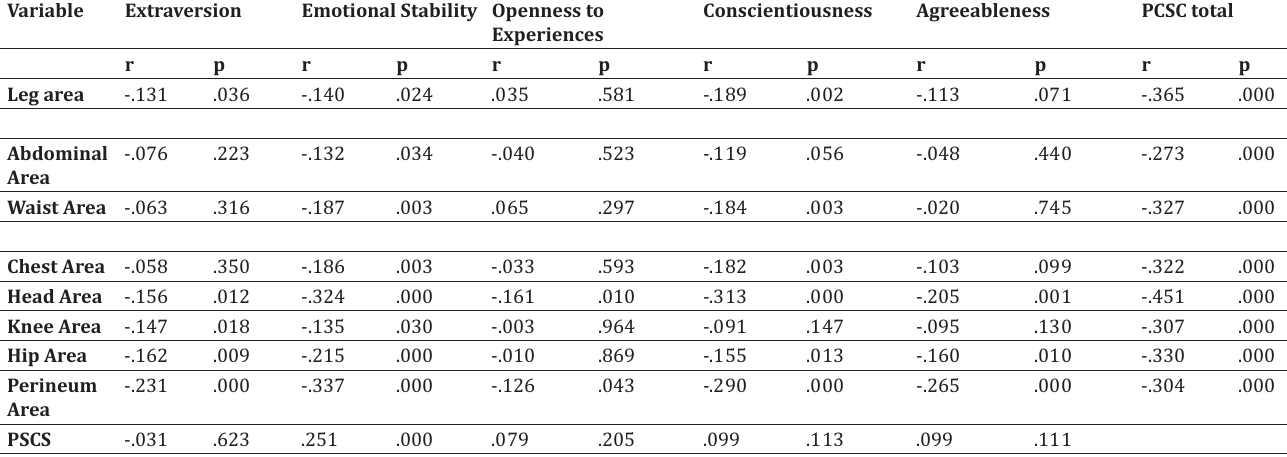
TIPI Sub-Dimensions and PSCS Relationship Between Total Mean Scores Averages (n=258)